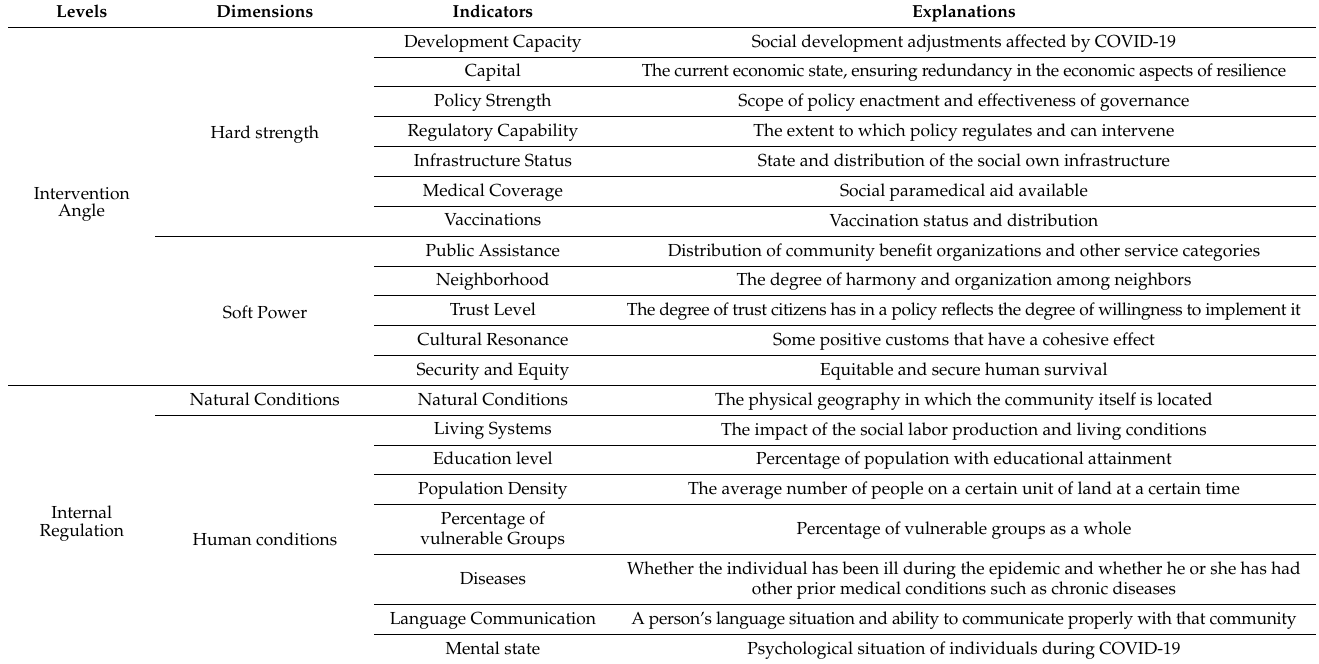
Table 4. Division of research perspectives of social resilience to